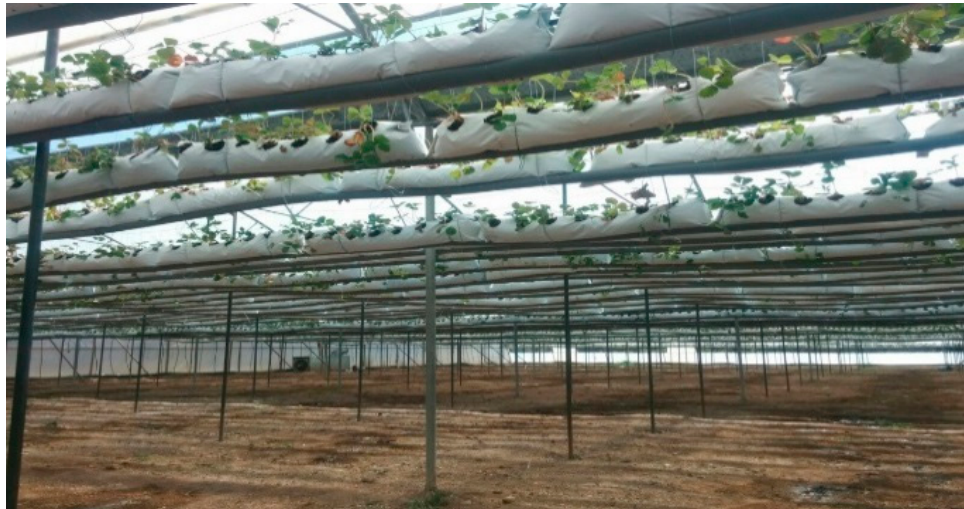
Figure 5. A strawberry high-tech urban farm in Rafsanjan.